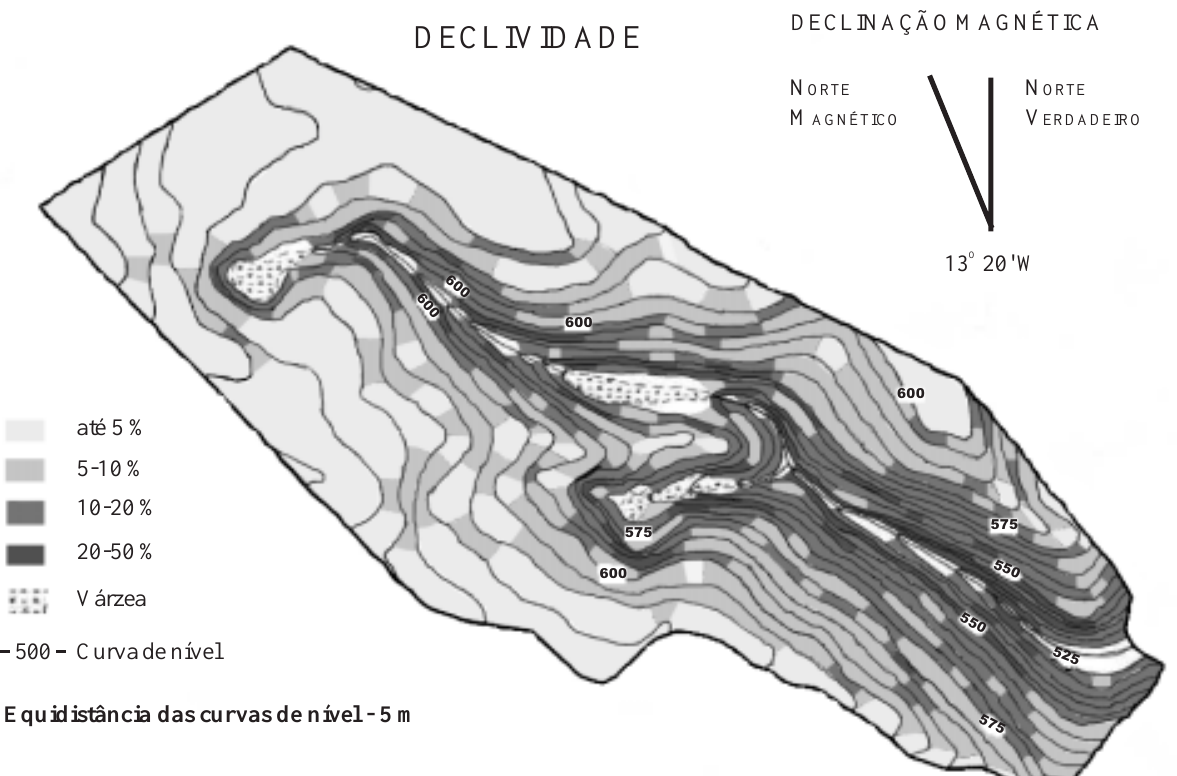
Figura 1. Mapa da bacia hidrográfica do córrego Unda com as curvas de nível, cotas e relevo.